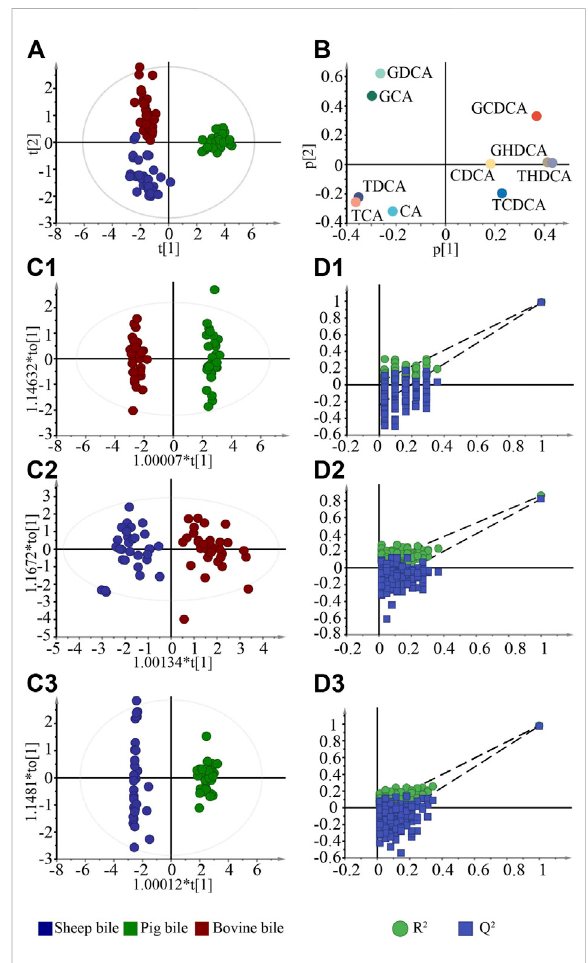
FIGURE 2 Multivariate statistical analysis for bile in negative ion mode. (A) . PCA score plots; (B) . Loading plots of components; (C1 – C3) . OPLS-DA score plots between various bile acids; (D1 – D3) . Permutation test of the OPLS-DA